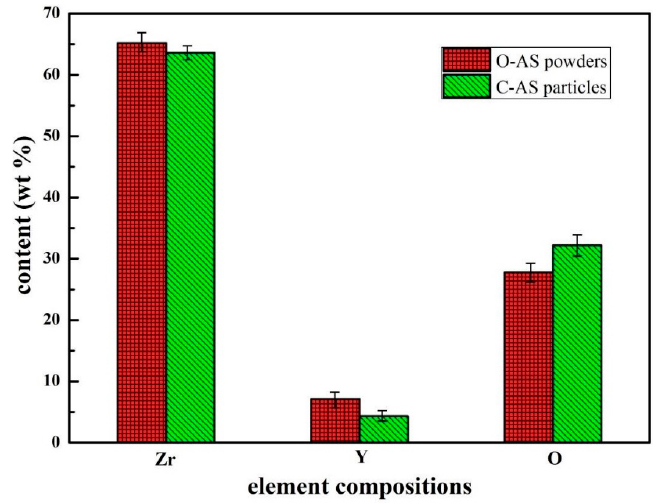
Figure 7. Element compositions of the O-AS powders and C-AS particles.